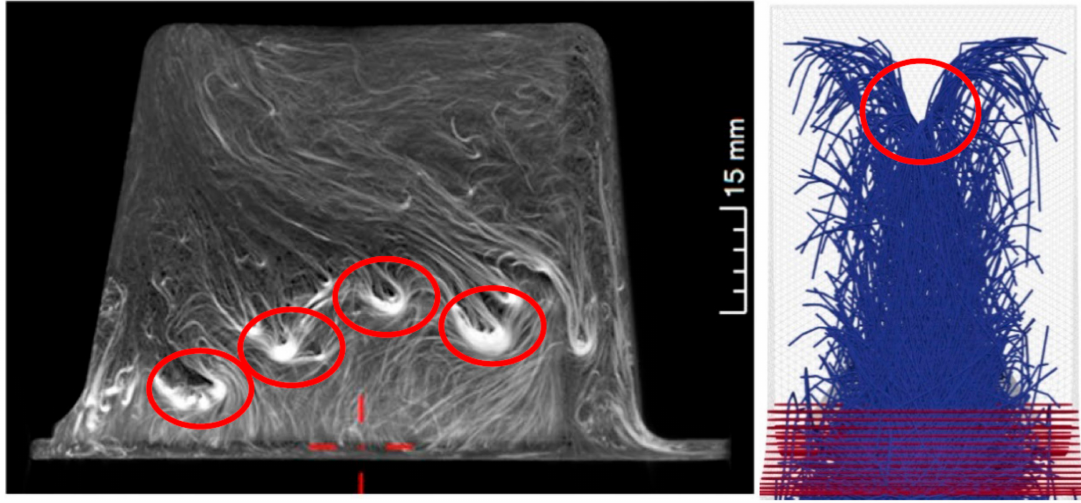
Figure 11. Examples of fiber bridging seen in real parts ( left , circles) and in the direct fiber simulation (DFS) ( right